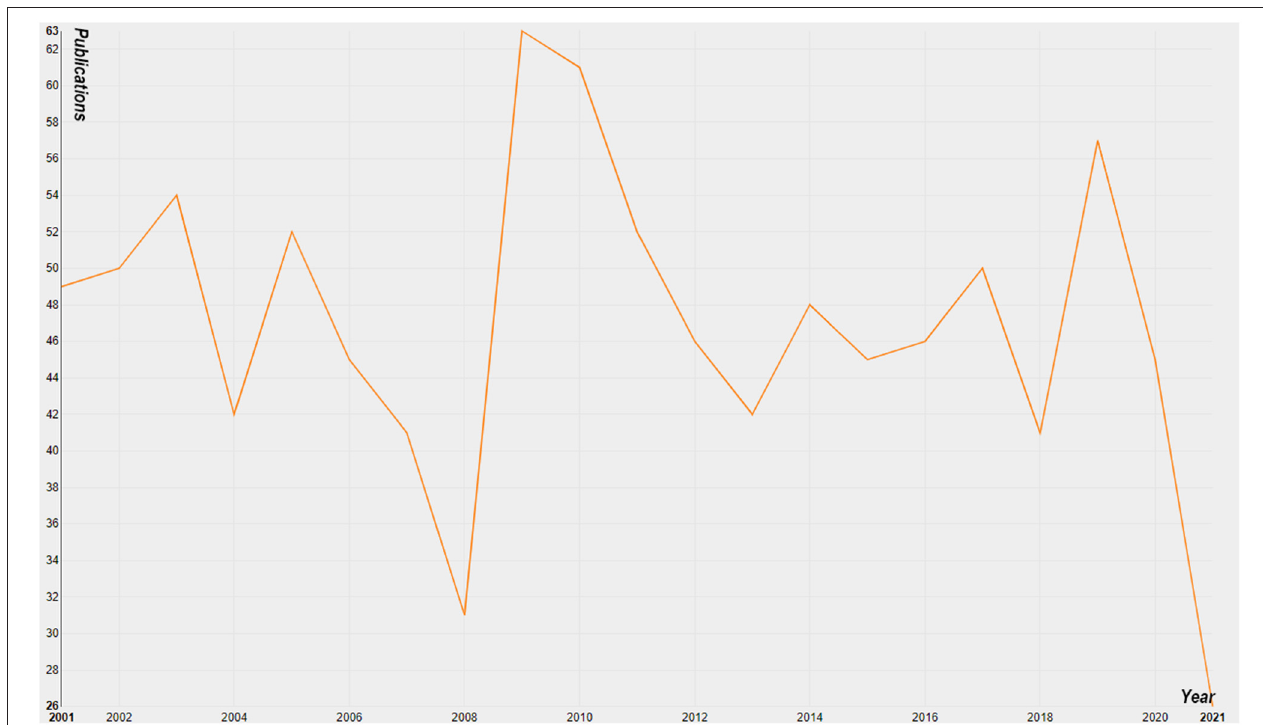
FIGURE 2 | The number of annual publications in MODS from 2001 to